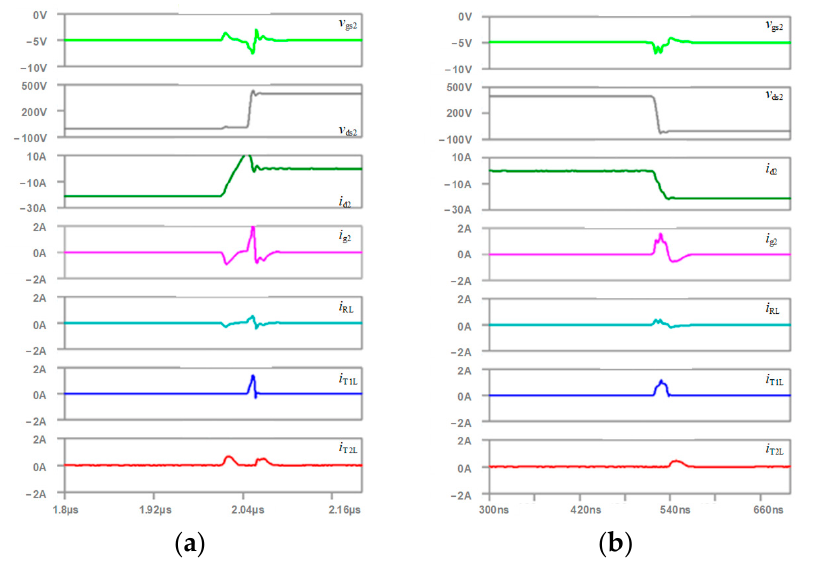
Figure 7. Simulation waveforms of the proposed driver. ( a ) during Q 1 turn-ON transition and ( b ) during Q 1 turn-OFF transition.